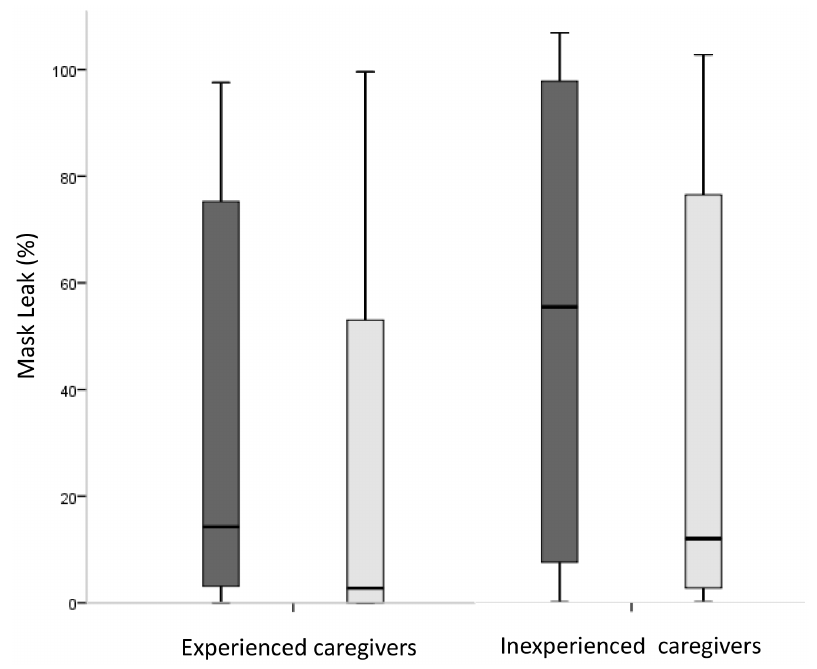
Figure 1. Median (IQR) mask leak (%) of experienced caregivers and inexperienced caregivers before (dark grey) and after (light grey) two-minute training using a self-inflating bag (SIB). The box plots show median values (solid black bars), IQR (margins of box), and range of data. doi:10.1371/journal.pone.0109049.g001 PLOS ONE |